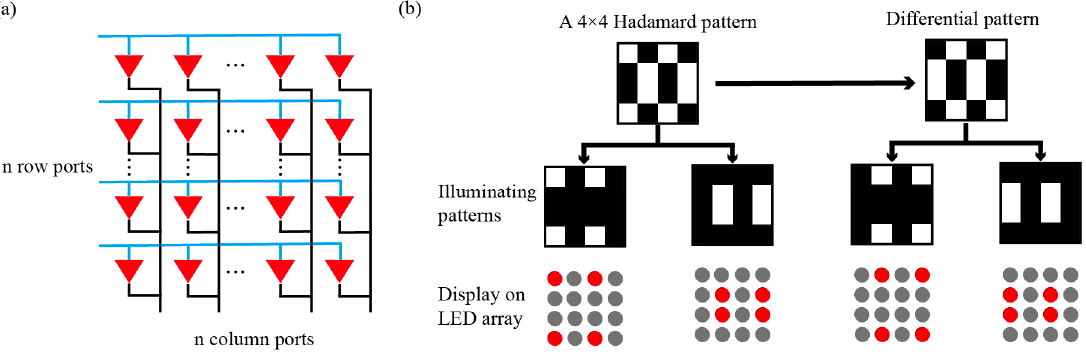
Figure 2. ( a ) Schematic diagram of the LED array design; ( b ) LED array display strategy.